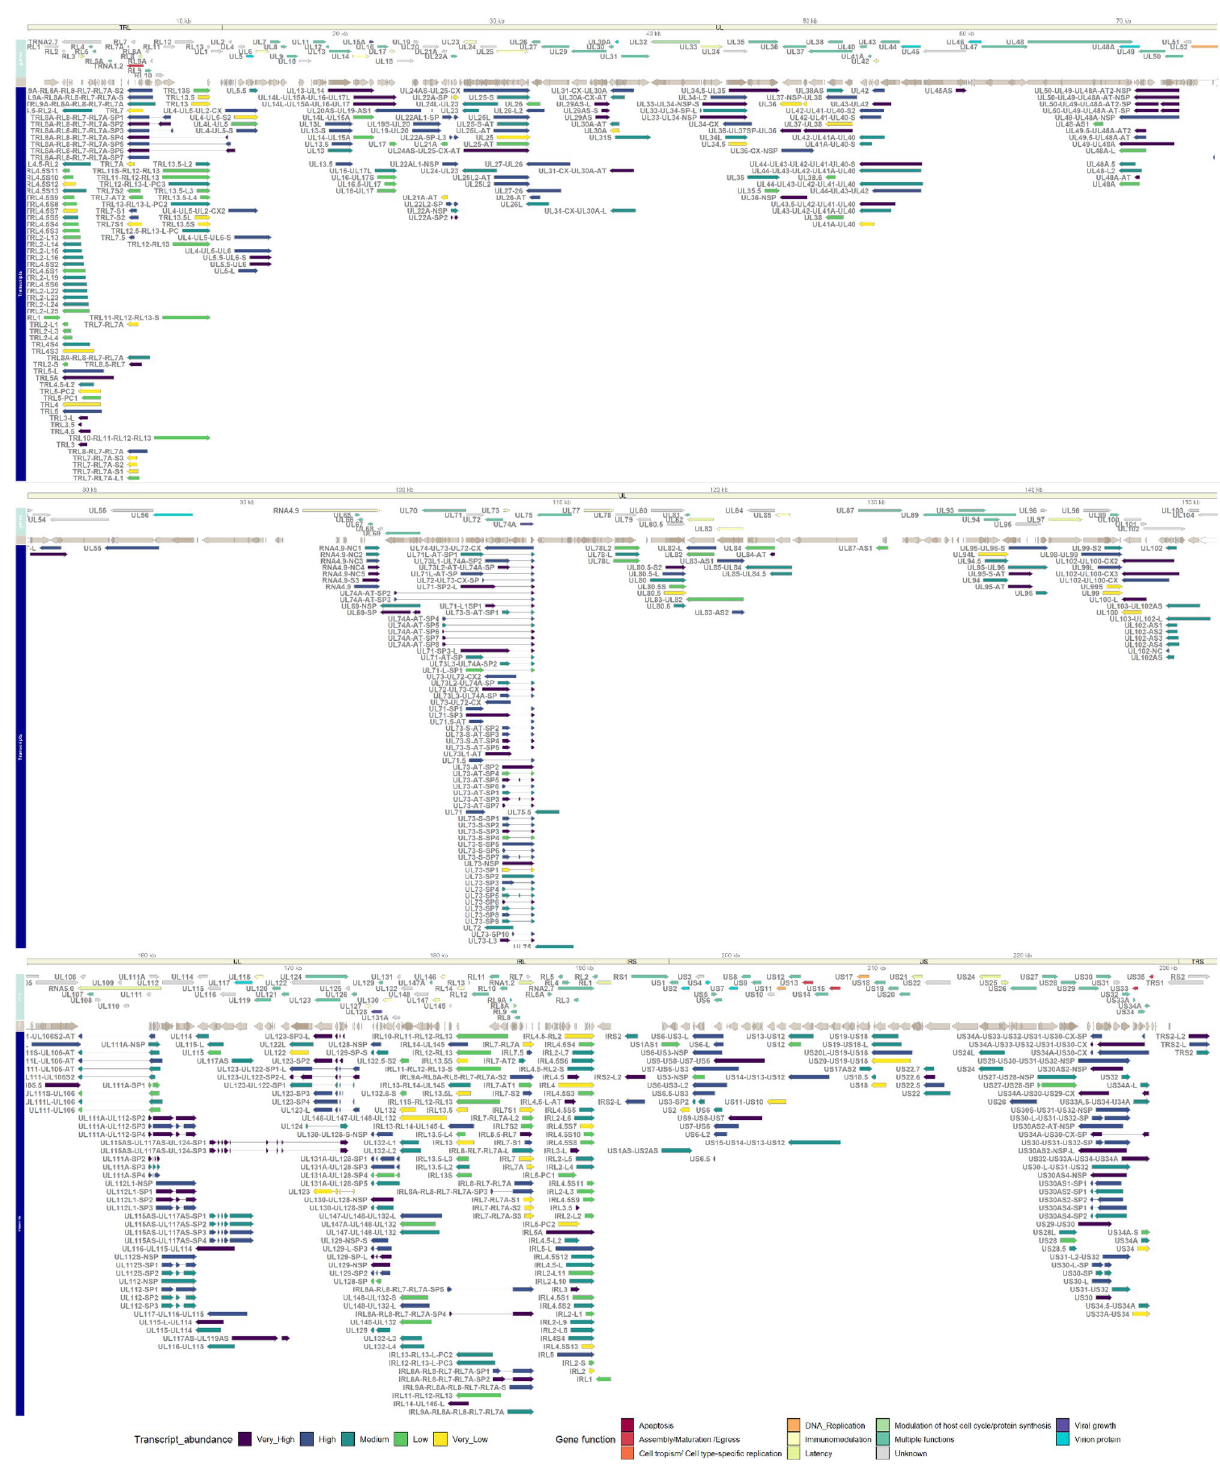
Figure 4. Genes (upper panel), ORFs (middle panel) and the annotated transcripts (bottom panel) of HCVM LT907985.2. Genes are colored according their function (as reviewed by Van Damme and Van Loock 29 ), while transcripts are colored according to their read counts: Very High: read count higher than 500; High: between 100 and 500; Medium: between 100 and 25; Low: between 25 and 10; and Very Low: between 2 and